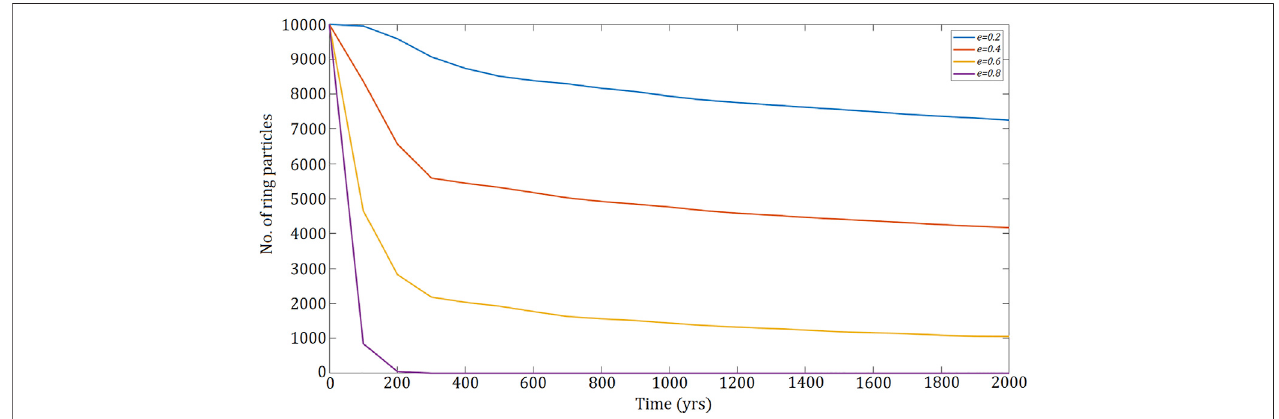
FIGURE 6 | The number of particles in all 4 retrograde ring models is plotting against time and shows that the majority of particles lost occurs within ~300 yrs.